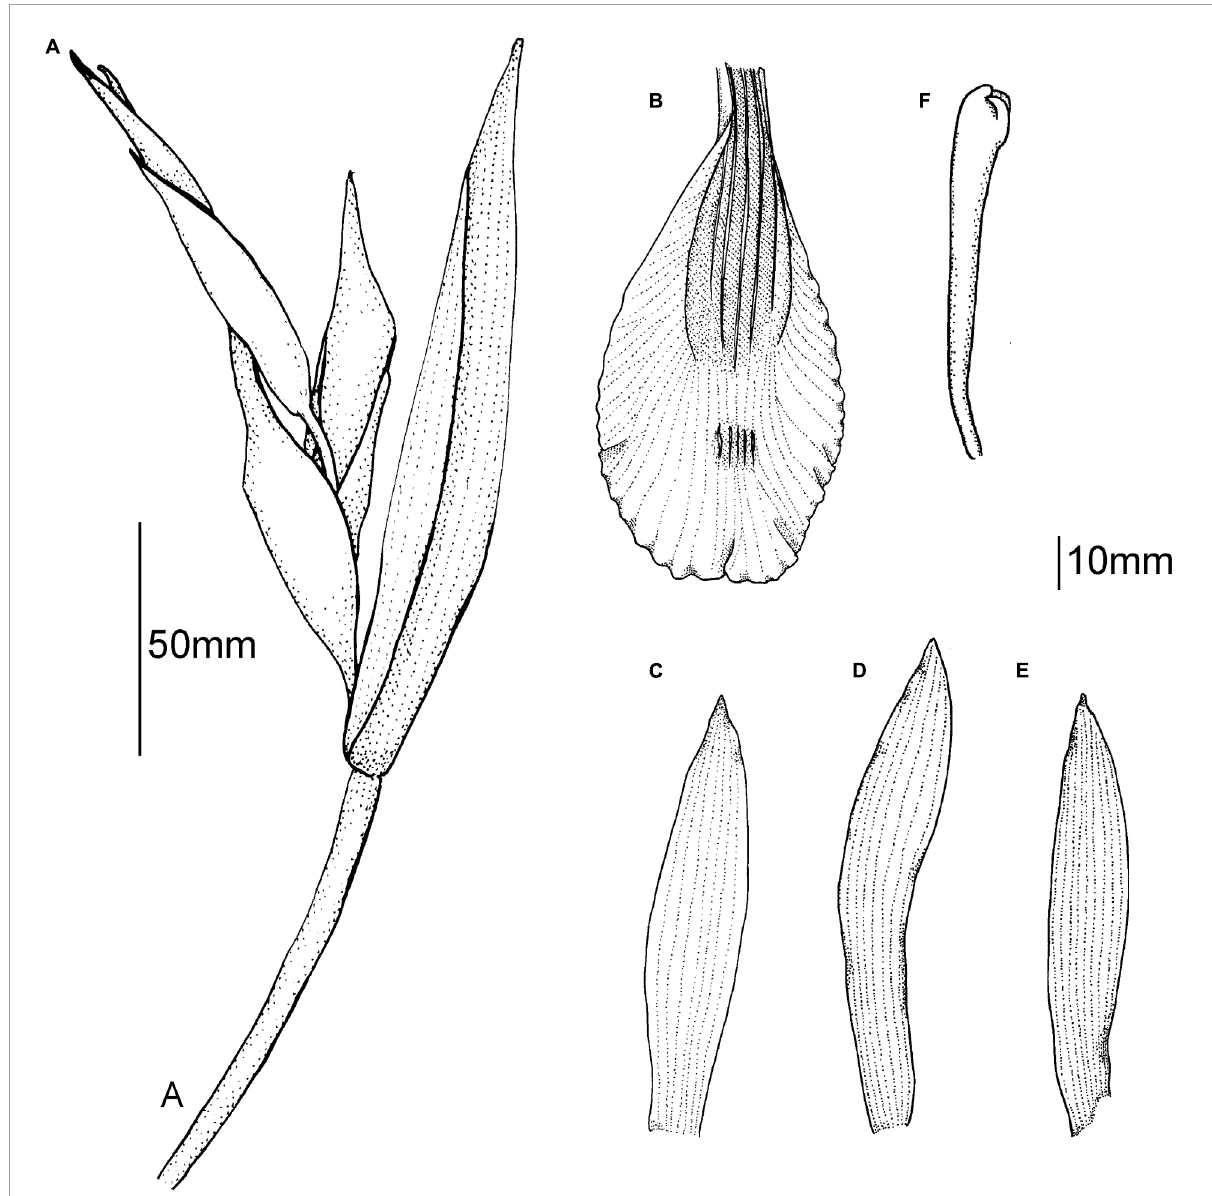
FIGURE15 Sobralia rosea Poepp. and Endl. (A) apical part of stem with inflorescence, (B) lip, (C) dorsal sepal, (D) petal, (E) lateral sepal, and (F) gynostemium, side view (drawn by P. Baranow from